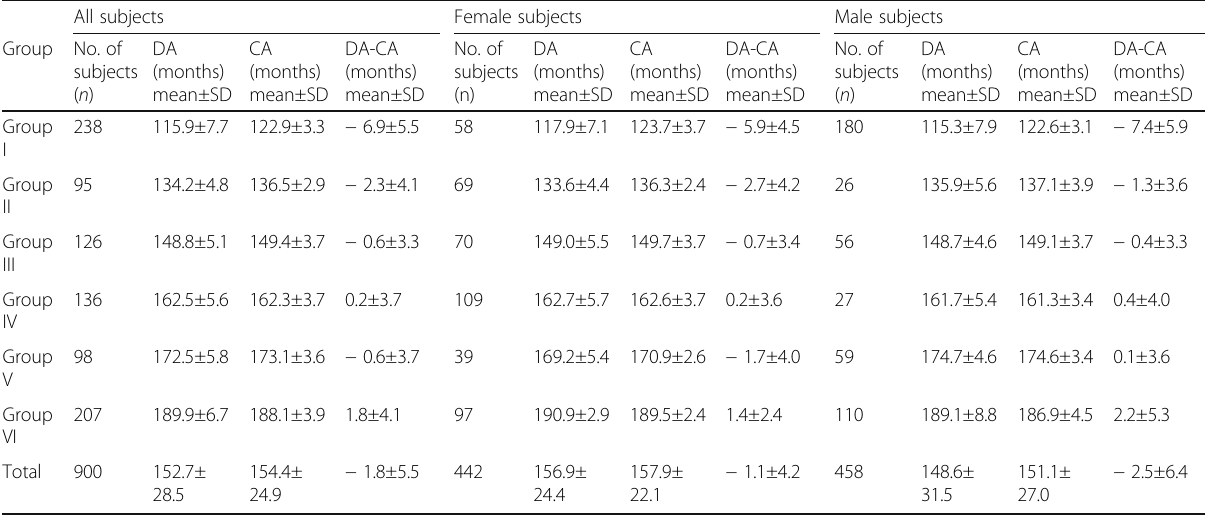
Table 2 Age-wise comparison of the mean dental age (using Nolla ’ s method) and mean chronological age in all the six age groups to understand the trend of growth in boys compared to girls as well as to the entire group All subjects